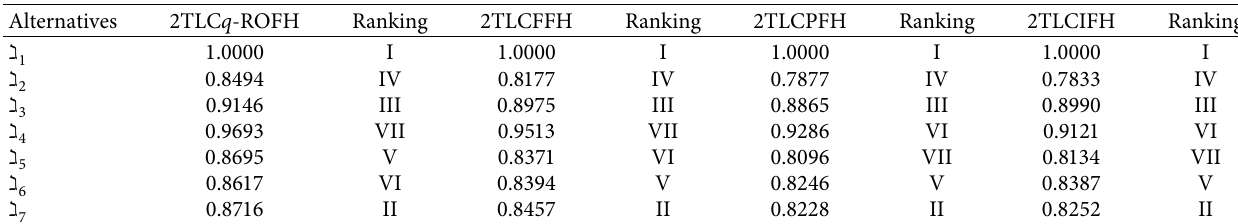
Table 17: Evaluation outcomes by utilizing different FSs based on the 2TLC q -ROFHWA operator. Alternatives